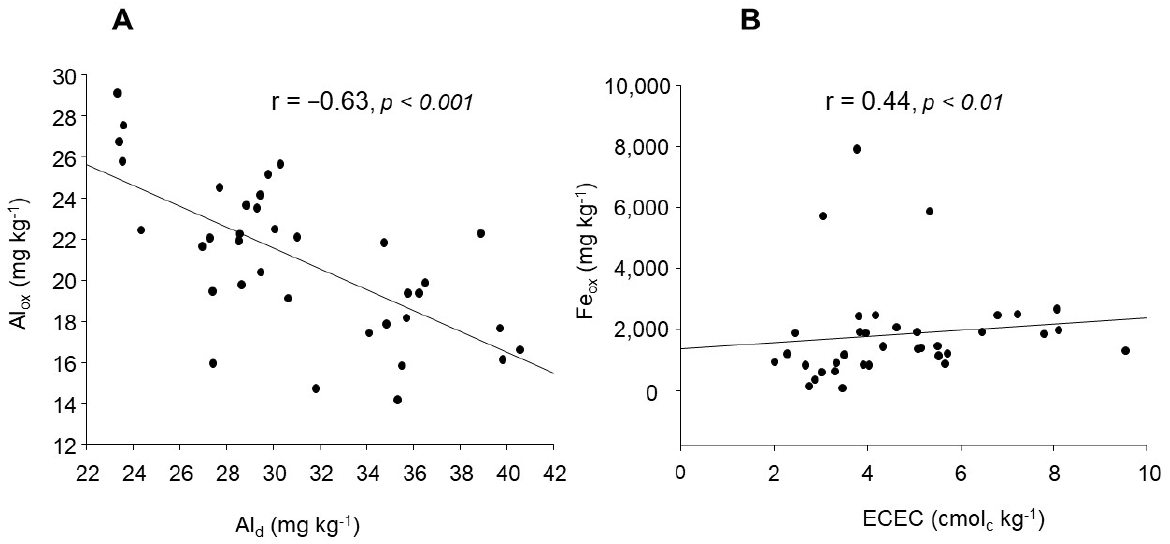
Figure 2. Correlations showing ( A ) a positive correlation between Al d and Al ox and ( B ) a negative correlation between Fe ox and ECEC for the Dompem soils. Table 4. Pearson and Spearman correlation coefficients for the Dompem soils. Table 3. Pedogenic Al and Fe contents and the active Fe ratio in soils of different farm types from Dompem ( n = 9) and Adansam ( n = 11) with coefficients of variation and p ‐ values.